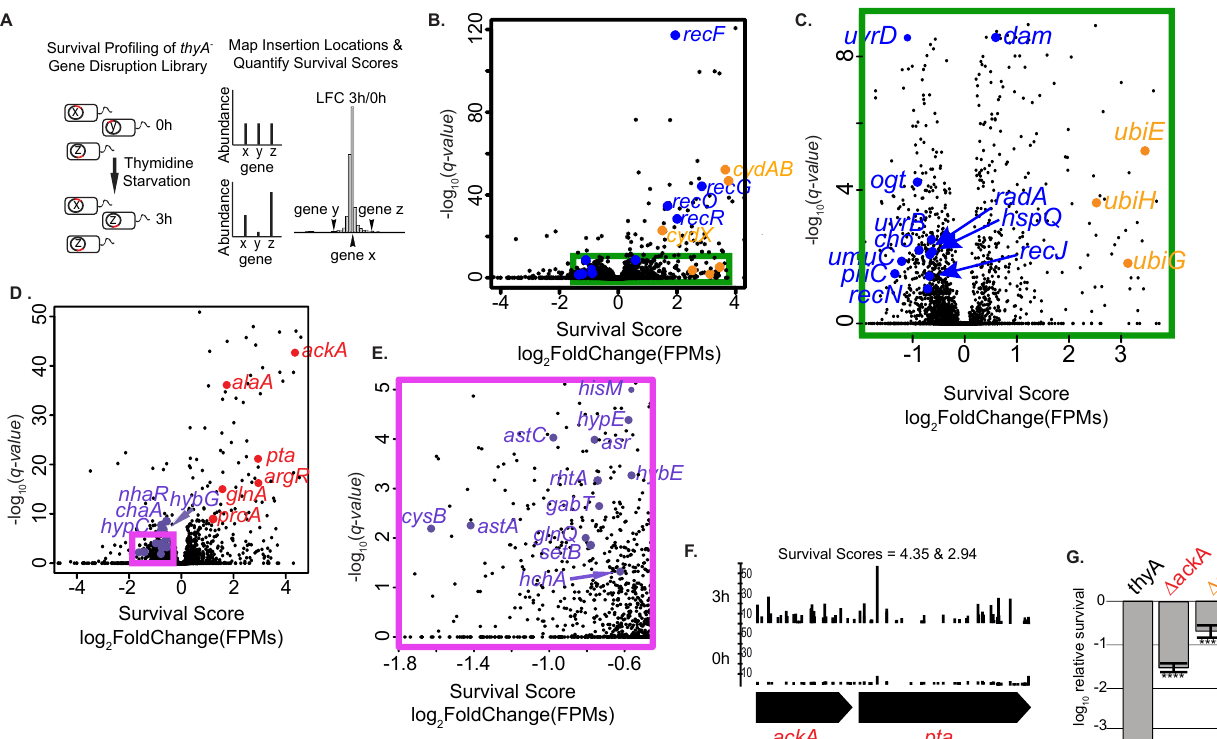
Fig 1. Systematic genetic survey of TLD by Tn-seq reveals a novel role for pH homeostasis. (A) A transposon insertion library was generated in the MG1655 thyA - strain and starved for thymidine. DNA adjacent to each insertion was amplified and sequenced at the beginning of the selection and at 3h. For each gene, the survival score is the log 2 fold change of normalized reads at 3h/0h. (B-C) Volcano plot of survival score and significance showing genes in previously known pathways in color. Here and in the rest of this work, orange represents genes associated with respiration/ROS and blue represents genes involved in DNA replication/repair. Significance was calculated using an exact rate ratio test (using the rateratio.test R package) with a Benjamini & Yekutieli correction [103]. (C) is an inset for the area in the rectangle pictured in (B). (D-E) Volcano plot of survival score and significance showing in color genes from candidate lists that modulate cytoplasmic pH. Disruptions in genes involved in proton influx, or in lowering substrates needed for deacidification, have positive survival scores (shown in red). Conversely, disruptions in genes whose products are directly involved in proton consumption or producing substrates required for deacidification systems have negative survival scores (in light blue). (E) is an inset for the area in the rectangle pictured in (D). (F) Frequency of transposon insertions along the length of two newly identified TLD contributors at 0h and at 3h thymidine starvation. The enhancements at 3h are visualized using the Integrated Genome Browser [104]. The frequencies of each insertion site are shown in read counts per million. (G) Enhanced survival of validated genes. Candidates were validated by transferring Keio collection knockout alleles into MG1655 thyA - , and assessing their survival at 3h of thymidine starvation. All death assays, unless otherwise stated, were performed at 37˚C. Relative survival was measured for at least three independent experiments, with error bars representing standard error of the mean. p -values for all death assays were calculated using a Welch t-test. � P < 0.05, �� P < 0.01, ��� P < 0.001, ���� P < 0.0001. Here and in the rest of this work, red color represents genes in the acetate dissimilation pathway.